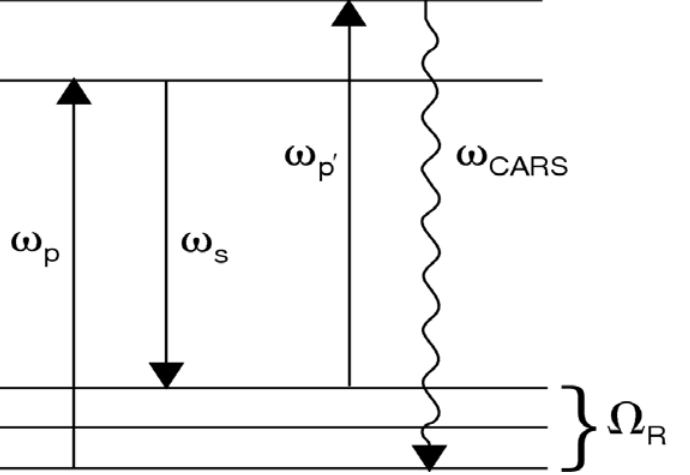
Figure 8. Schematic diagram depicting coherent anti-Stokes Raman scattering.  represent the pump, Stokes, and probe sources, respectively.   p’ excitation of the medium that is coherently excited by the pump and Stokes sources. Scattering of the probe source by the vibrational excitation results in the anti-Stokes beam at frequency  CARS